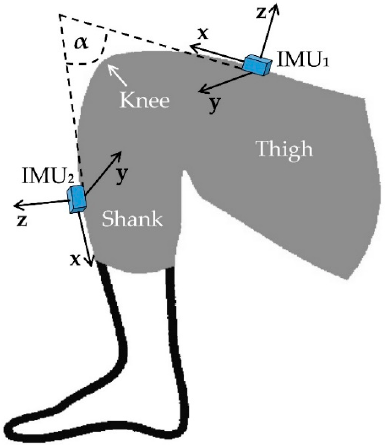
Figure 11. Inertial measurement unit (IMU) sensors’ orientation and position for knee angle